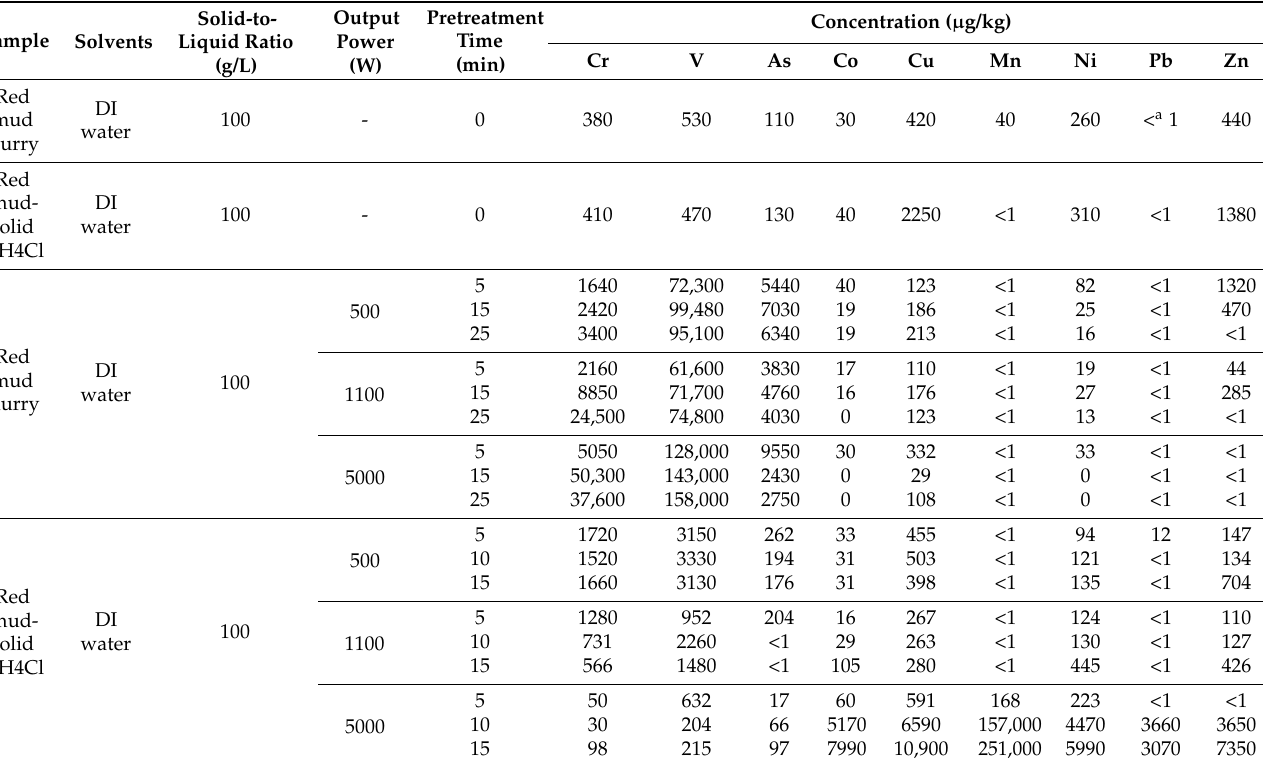
Table 2. Element concentrations leached from microwave-heated red mud slurry and red mud-solid NH 4 Cl samples. Sample